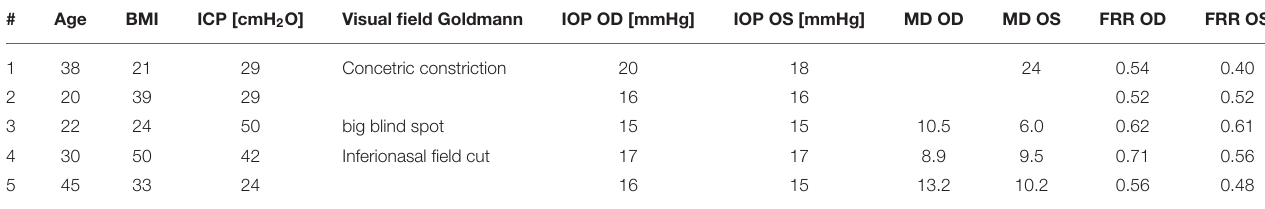
TABLE 1 | Summary of the patient